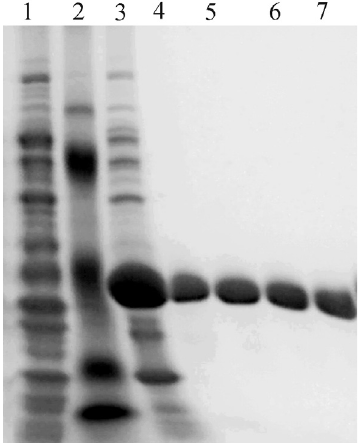
Figure 5 - SDS-PAGE of recombinant PsChiC . The gel was stained with Coomassie brilliant blue R-250. Lane 1 - induced BL21(DE3)/pET30a, lane 2 - molecular mass markers (105, 71, 50, 35 and 25 kDa), lane 3 - BL21(DE3)/pET PsChiC induced for 4 h, lanes 4-7 - purified PsChiC